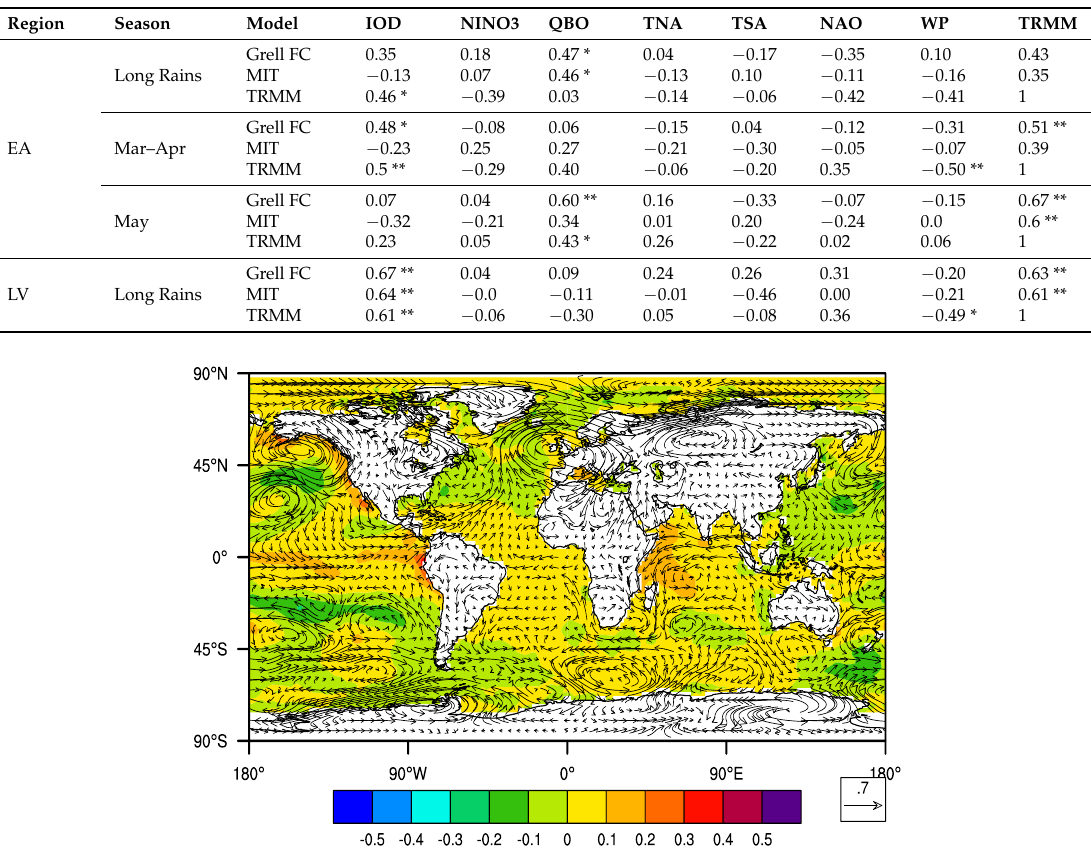
Figure 12. Wind and sea surface temperature anomaly composites during Mar–Apr for EOF1 over East Africa region using the TRMM